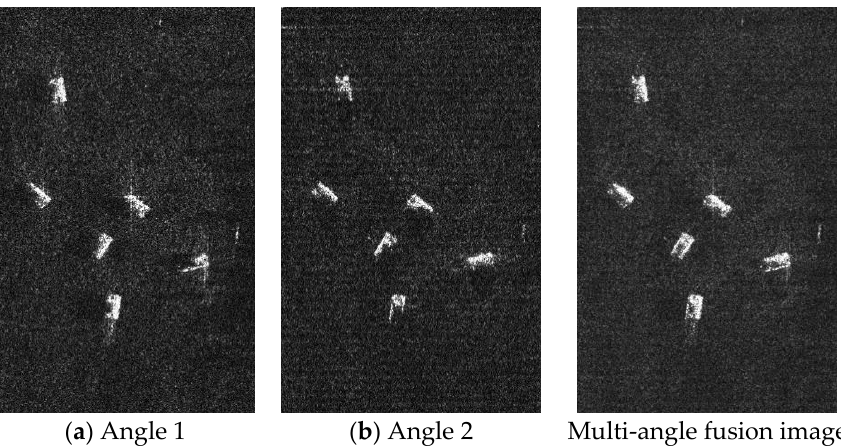
Figure 15. Image fusion results of proposed method.